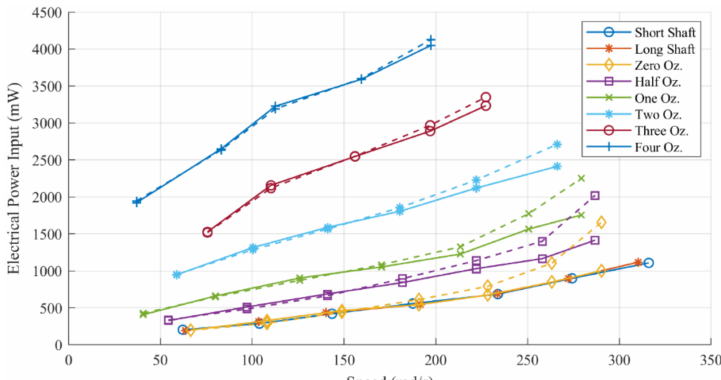
Figure A3. Electrical power input measurements at various duty cycles and load configurations with unadjusted (dashed line) and adjusted (solid line) data values shown. The adjusted values are determined by finding the electrical power input di ff erence between the experiments with and without the pulley attached, interpolated at the speed of interest. This di ff erence is then subtracted from the measurements of the weighted pulley experiments to provide the adjusted electrical power input. As expected, the adjusted values for the zero ounce measurement align with the short shaft and long shaft measurements. The impact of the pulley’s inertia on the measured power input is most noticeable at speeds above 160 rad / s (25.5 Hz). To accommodate both flapping-wing mechanisms, di ff erent gearboxes with the same gear ratios but unique shaft lengths were used. This test showed that the di ff erent gearboxes alone did not alter the load on the electric